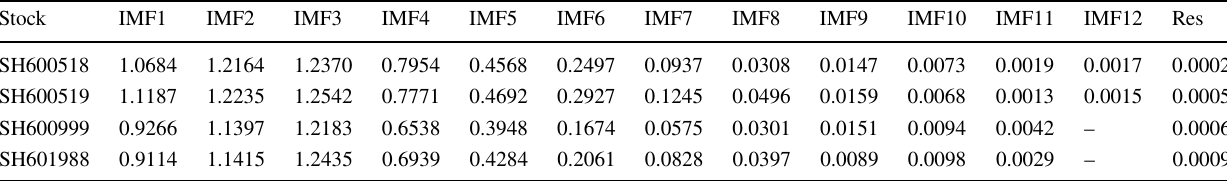
Table 3 The values of sample entropy of IMFs